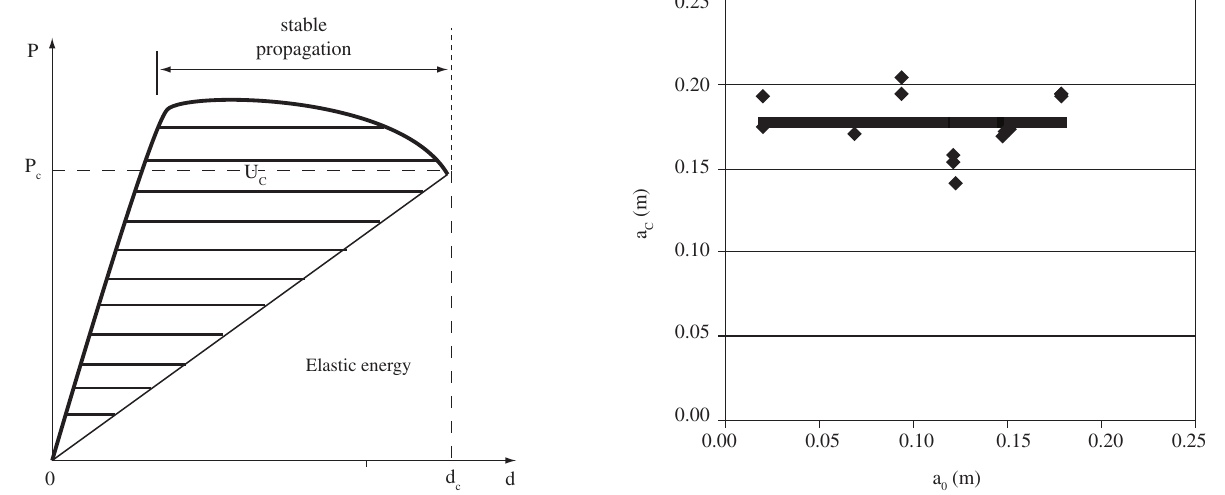
, vs. notch length, a c 0